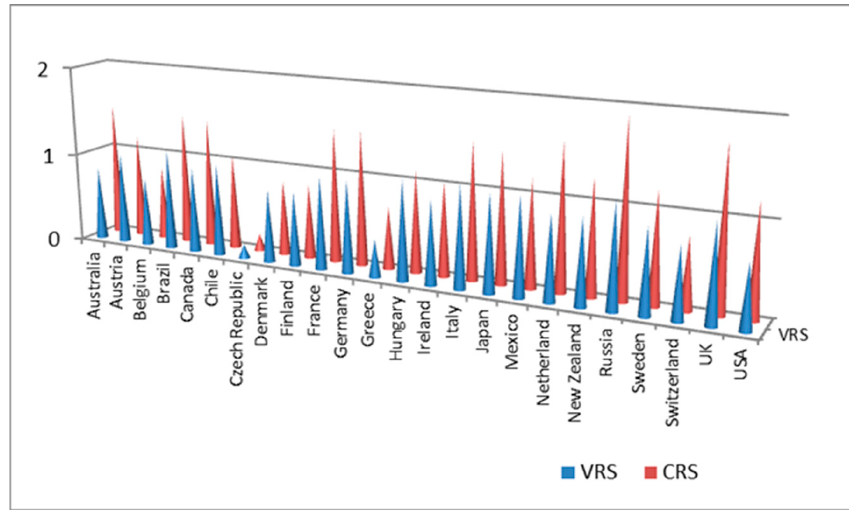
Figure 6. Investment efficiency of Chinese outward FDI on wellbeing from SDEA approach. Table 5. Interconnections of OECD destination countries for Chinese outward FDI using Tabu